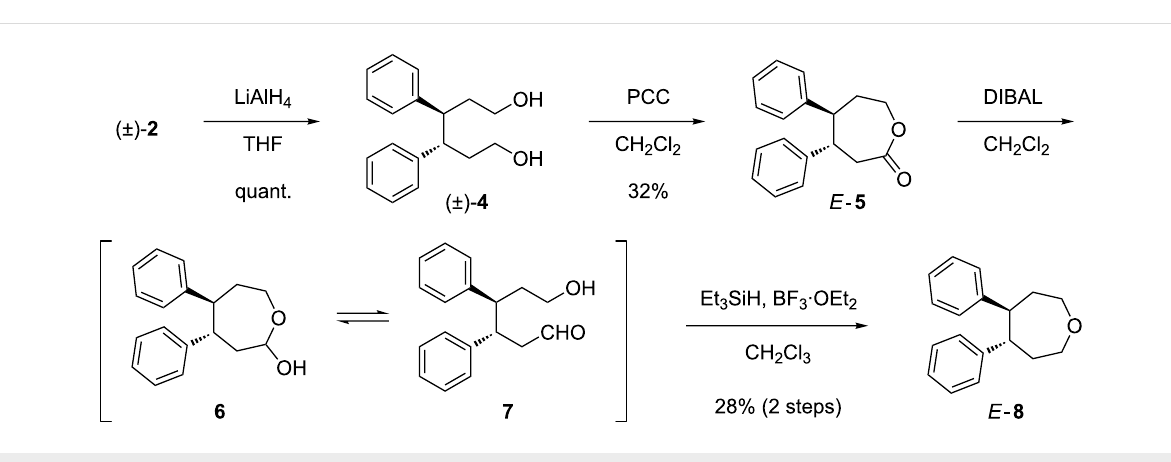
Scheme 1: Chemical conversion of (±)- 2 into E - 5 and E - 8